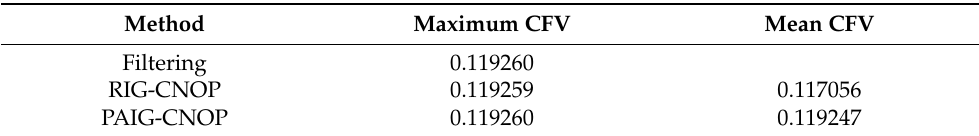
Figure 4. The distribution of the CFVs corresponding to the initial guesses generated by the different methods at point C 1 , T = 400. Table 3. Statistical analysis of the CFVs corresponding to the initial guesses generated by the different methods at point C 1 , T = 400.